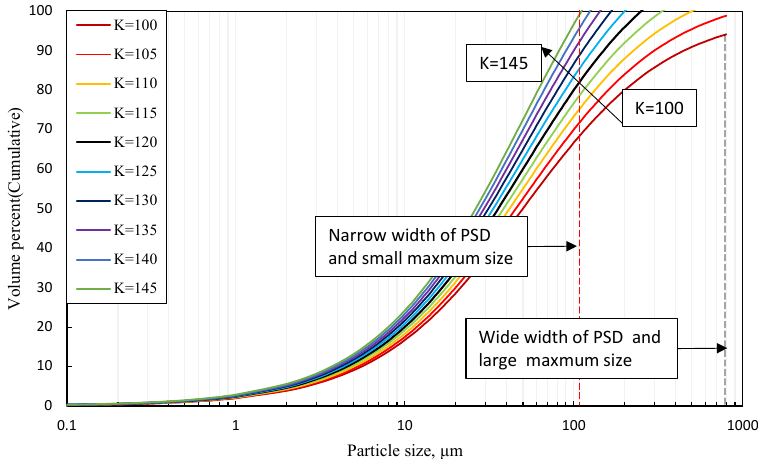
Figure 5. Model curve under different Coefficient K.